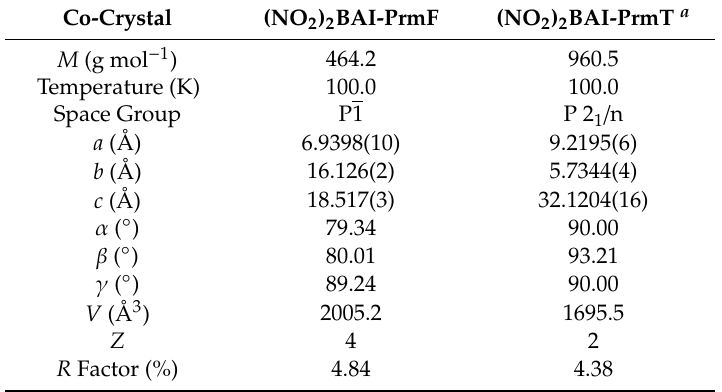
Table 1. Crystallographic data for (NO 2 ) 2 BAI-PrmF and (NO 2 ) 2 BAI-PrmT complexes.